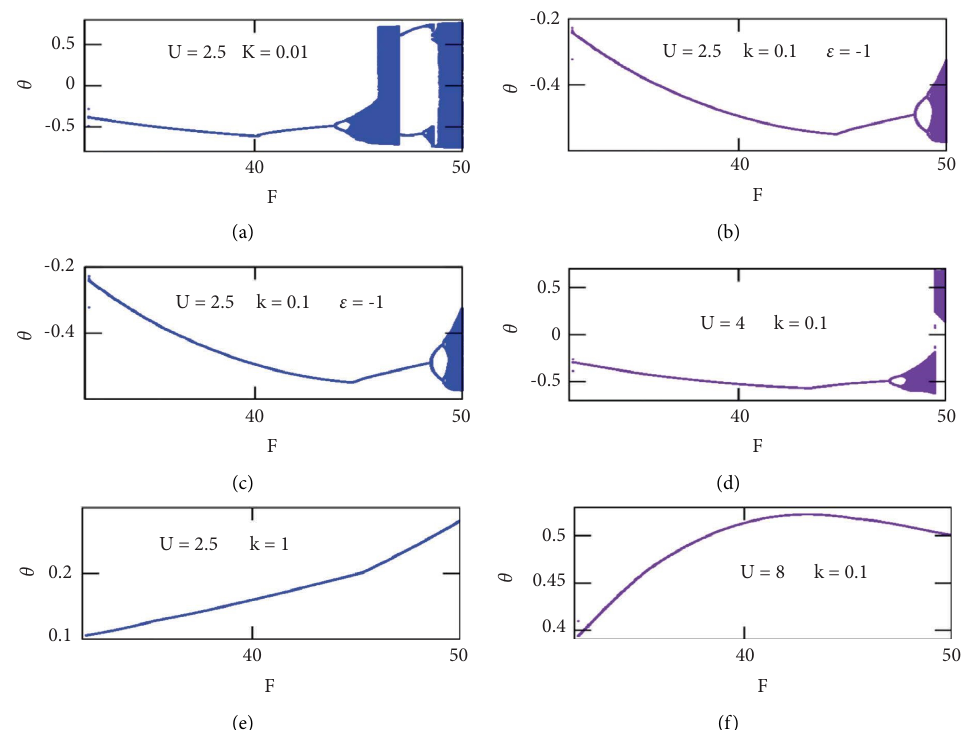
Figure 9: Effect of the parameters K and U on the bifurcation diagram for ϵ � − 1 ; α � 10 ; β � 1 ; Ω � 2 ; C .